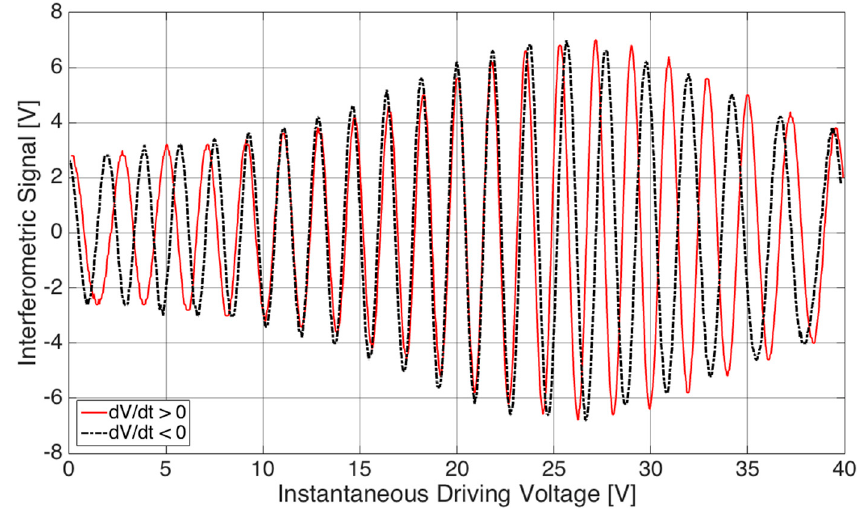
Figure 3. Interferometric signal as a function of the instantaneous driving voltage applied to the piezo-electric actuator. Red trace: results for d V /d t > 0; black dashed trace: results for d V /d t < 0.